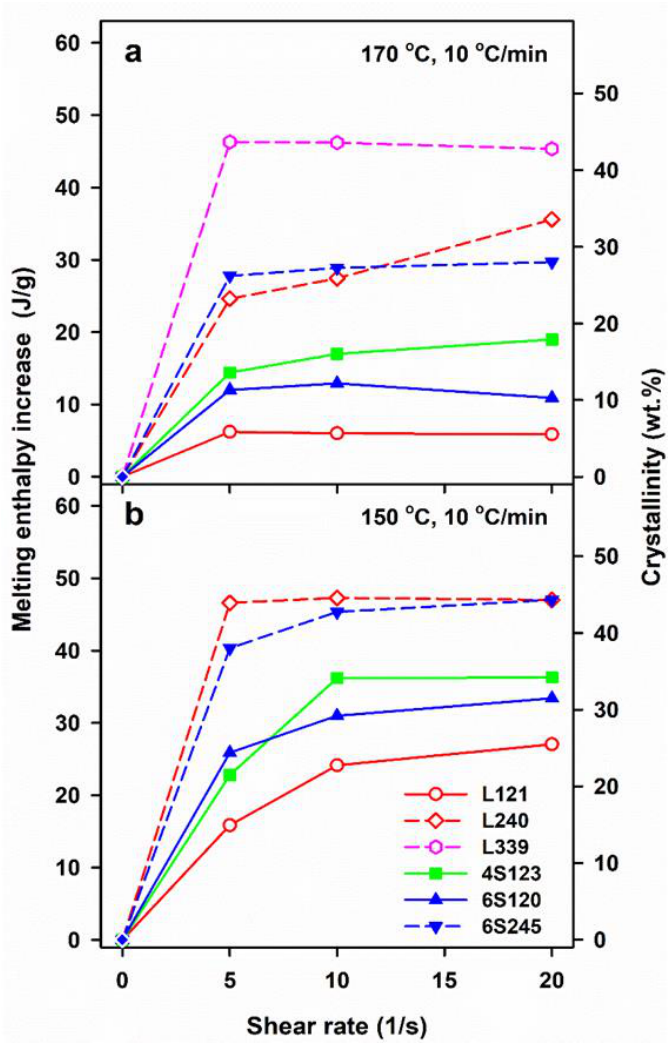
Figure 5. Increase of melting enthalpy, ∆ H mc - ∆ H mcq , of crystalline phase formed in PLLAs during cooling at 10 °C/min caused by shearing at 170 C ( a ) and 150 °C ( b ) versus shear rate, 𝛾̇ . H mcq denotes the melting enthalpy of crystals formed during cooling at 10 °C/min in control specimens.